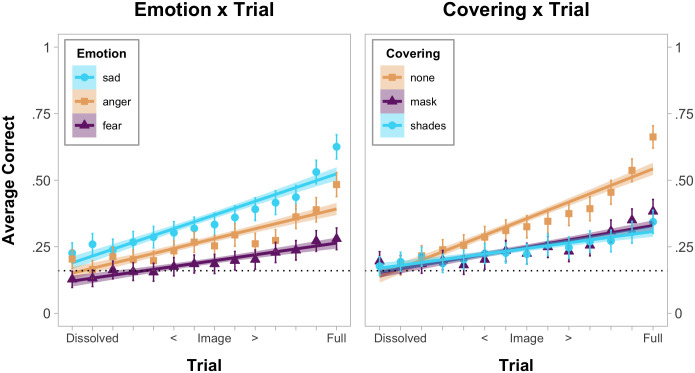
Linear regression and means for emotion x trial and covering x trial interactions.The dotted line indicates chance responding (1/6). Confidence intervals (95%) were estimated with bootstrapping (1,000 bootstrap estimates resampled 81 times from mean participant accuracy).